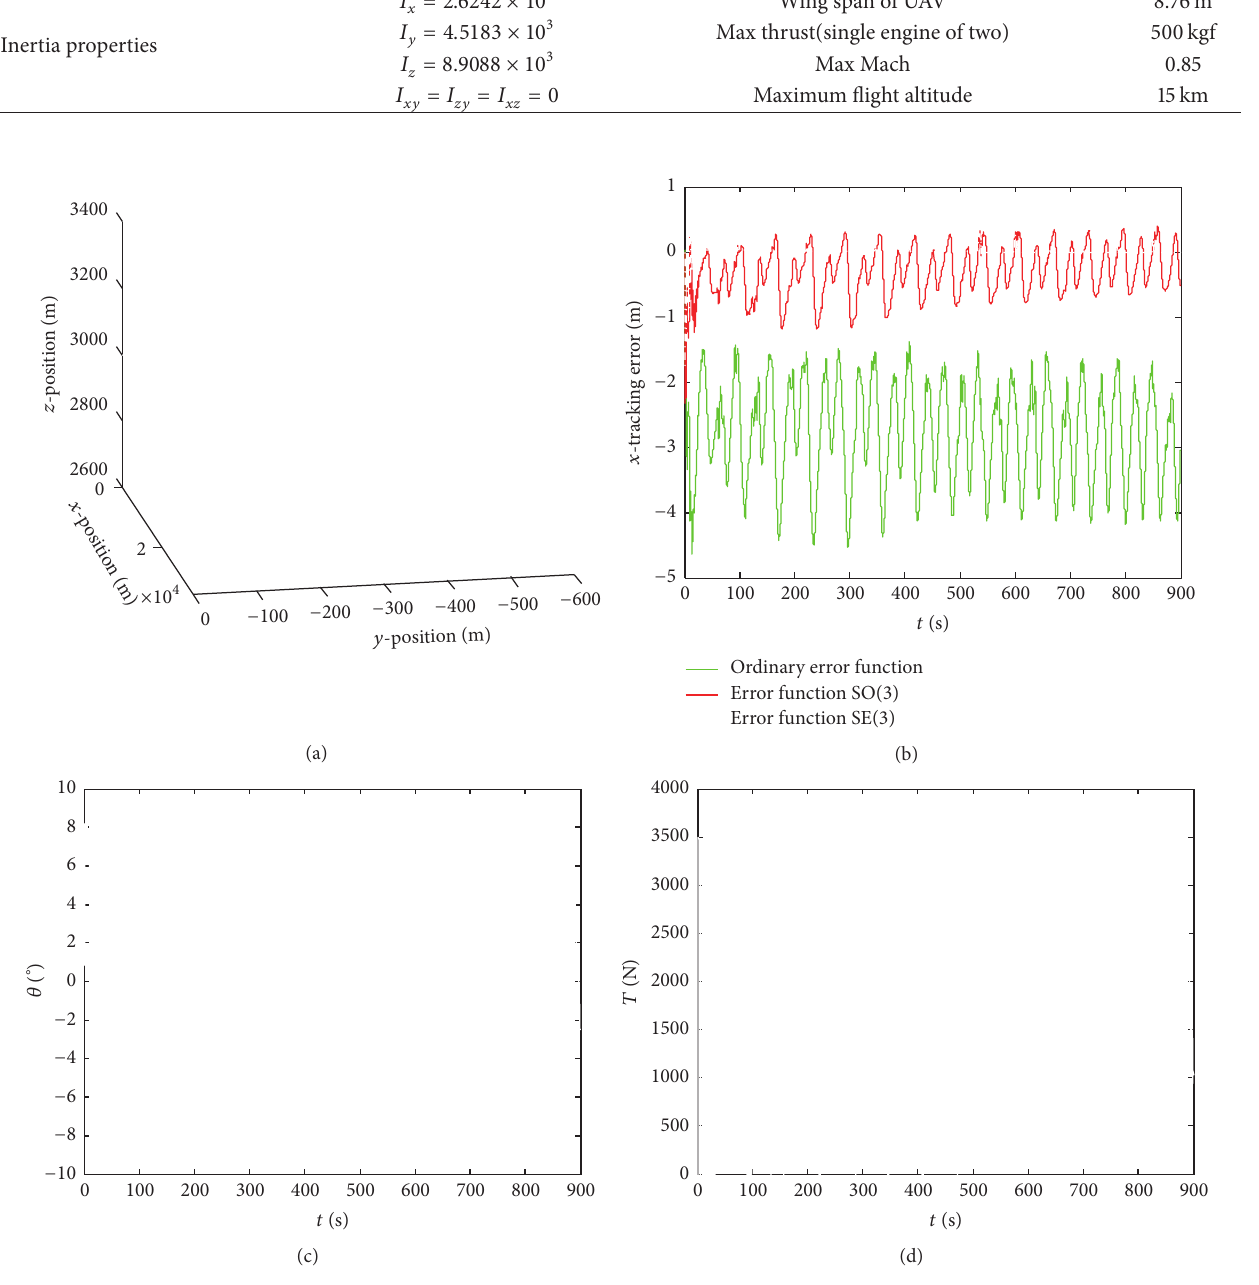
Figure 4: (a) Curve of the target trajectory. (b) A comparison of the forward errors. (c) Curve of the pitch angle. (d) Force of the thrust.